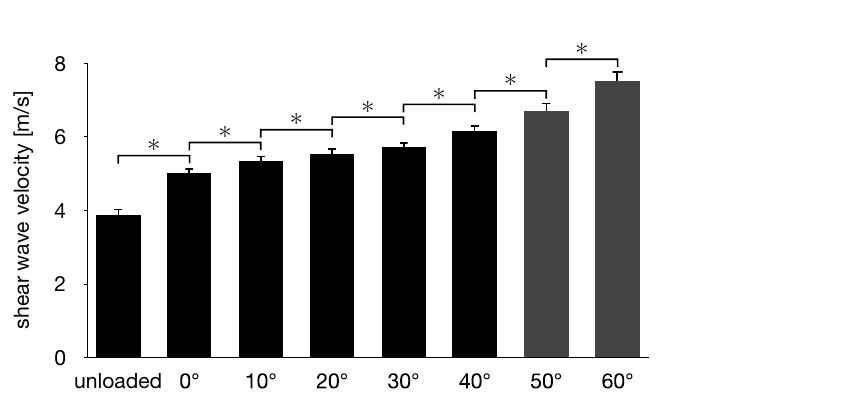
Figure 5. Gender-based comparisons of the three coefficients of the exponential function. The error bars indicate standard deviations. There were no gender-associated significant differences in the three coefficients of the exponential function.